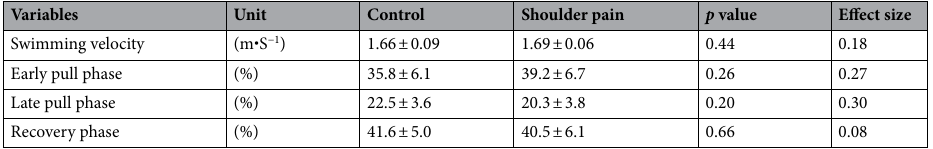
Table 2. Kinematic variables measured during the butterfly technique. The swimming velocity and rate of each phase were not different between the two groups.